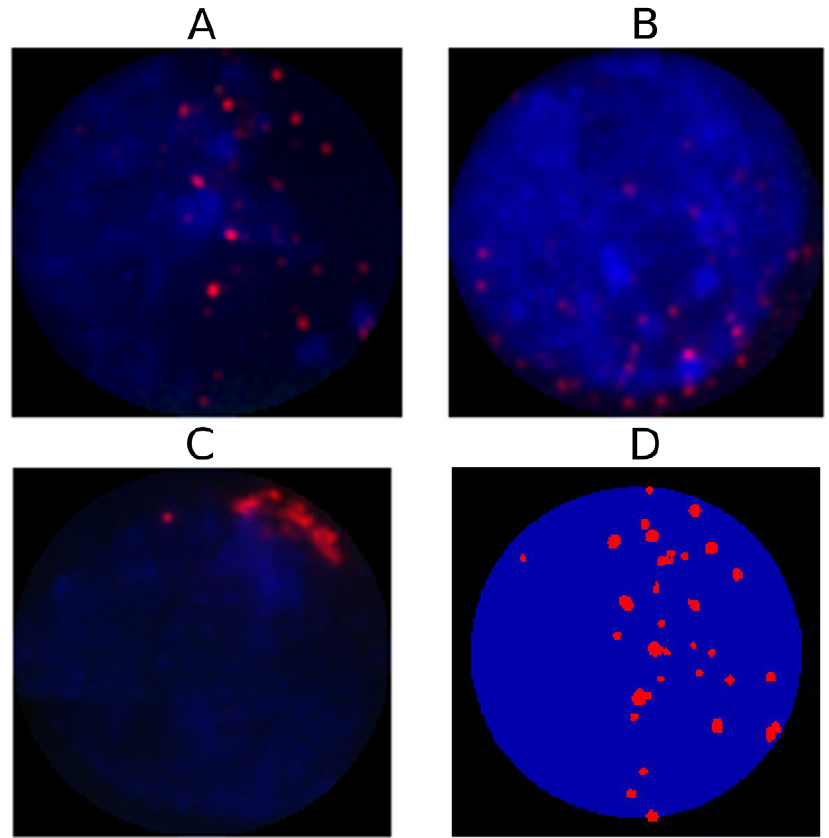
Figure 2. Experimental Ph1 2 meiocyte images and the associated identification of telomere positions. Ph1 + and tapetal nuclei look almost identical although tapetal cells do not form a telomere bouquet. A–C. Three separate Ph1 2 meiocyte nuclei showing different stages of bouquet formation. Each image has been sum-projected over z-stacks, with the DAPI stain shown in blue and the telomeres labelled in red. D. Data from A after the nucleus (in blue) and telomere clusters (in red) have been identified by our image processing.